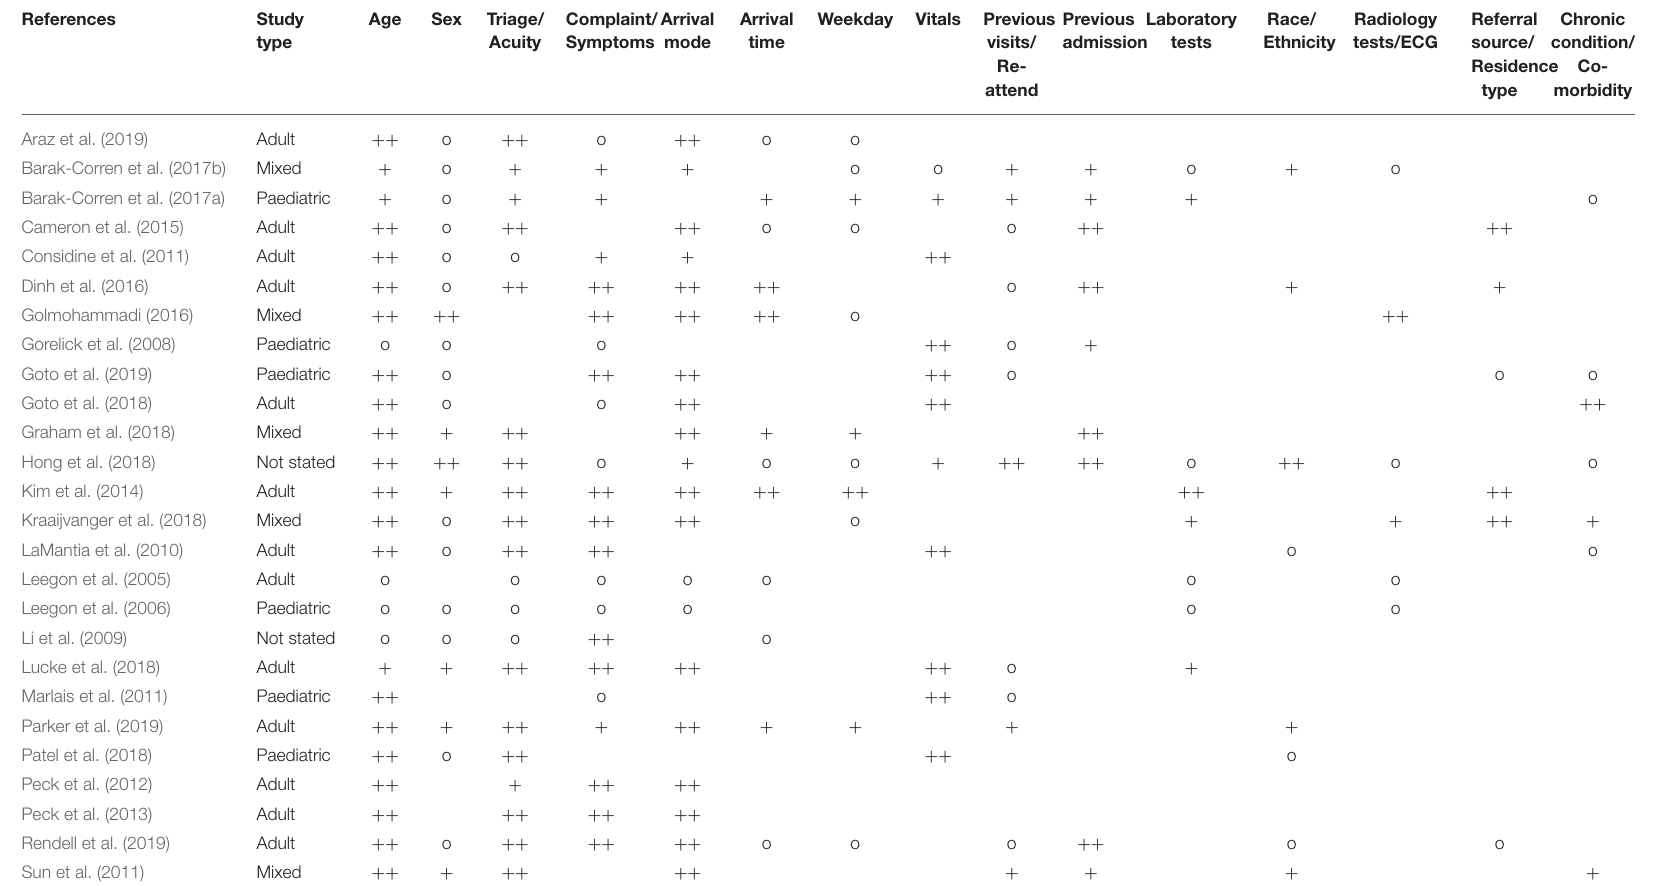
TABLE 1 | Top 15 variables considered for inclusion across 26 studies.